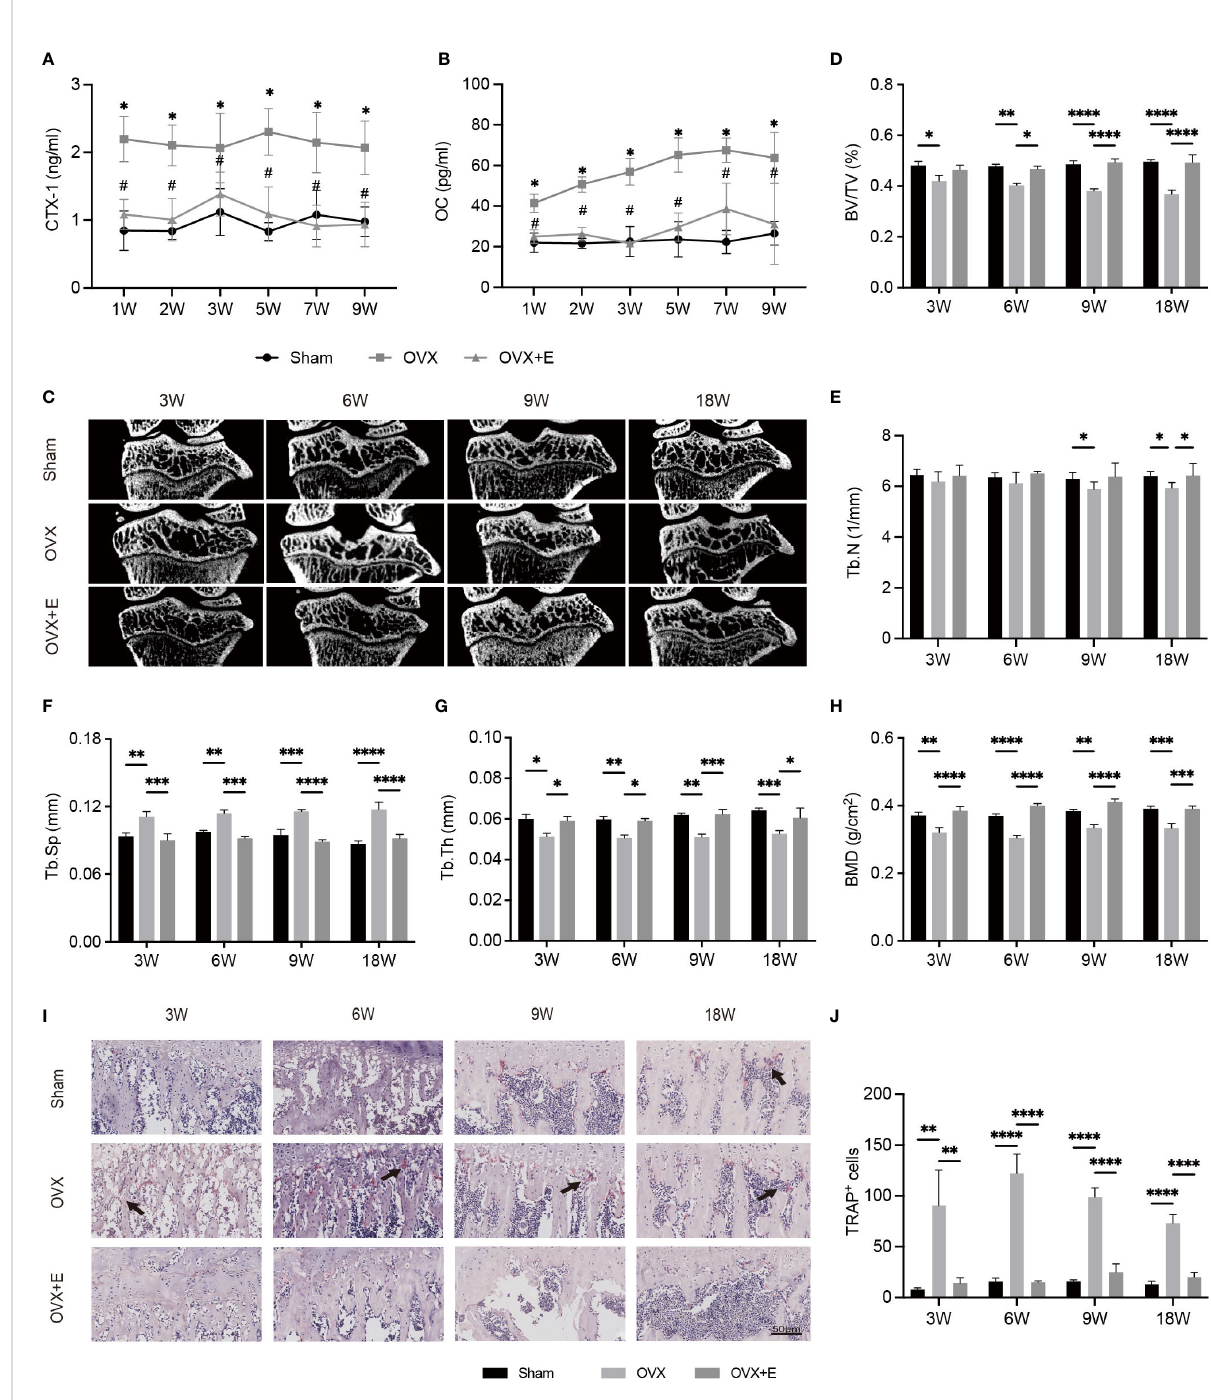
FIGURE 2 The alterations of subchondral bone after surgery from week 3 to week 18 in Sham, OVX and OVX+E rats. (A, B) The serum levels of CTX-I and OC (n = 7). *p< 0.05 vs. Sham group. #p< 0.05 vs. OVX group. (C) Representative m CT images of the proximal tibia (n = 7). (D – G) S ubchondral trabecular parameters (n = 7). (H) BMD (n = 7). (I) TRAP staining of the subchondral bone in the tibia. The black arrow indicates the activated osteoclasts (n = 7). (J) Quantitative analysis of the area of TRAP + cells per bone marrow area (mm 2 ). Scale bar, 50 m m. *p< 0.05, **p< 0.01, ***p< 0.001, ****p< 0.0001. BV/TV, bone volume/total volume. Tb. Sp, trabecular separation. Tb. N, trabecular number. Tb. Th, trabecular thickness. BMD, bone mineral